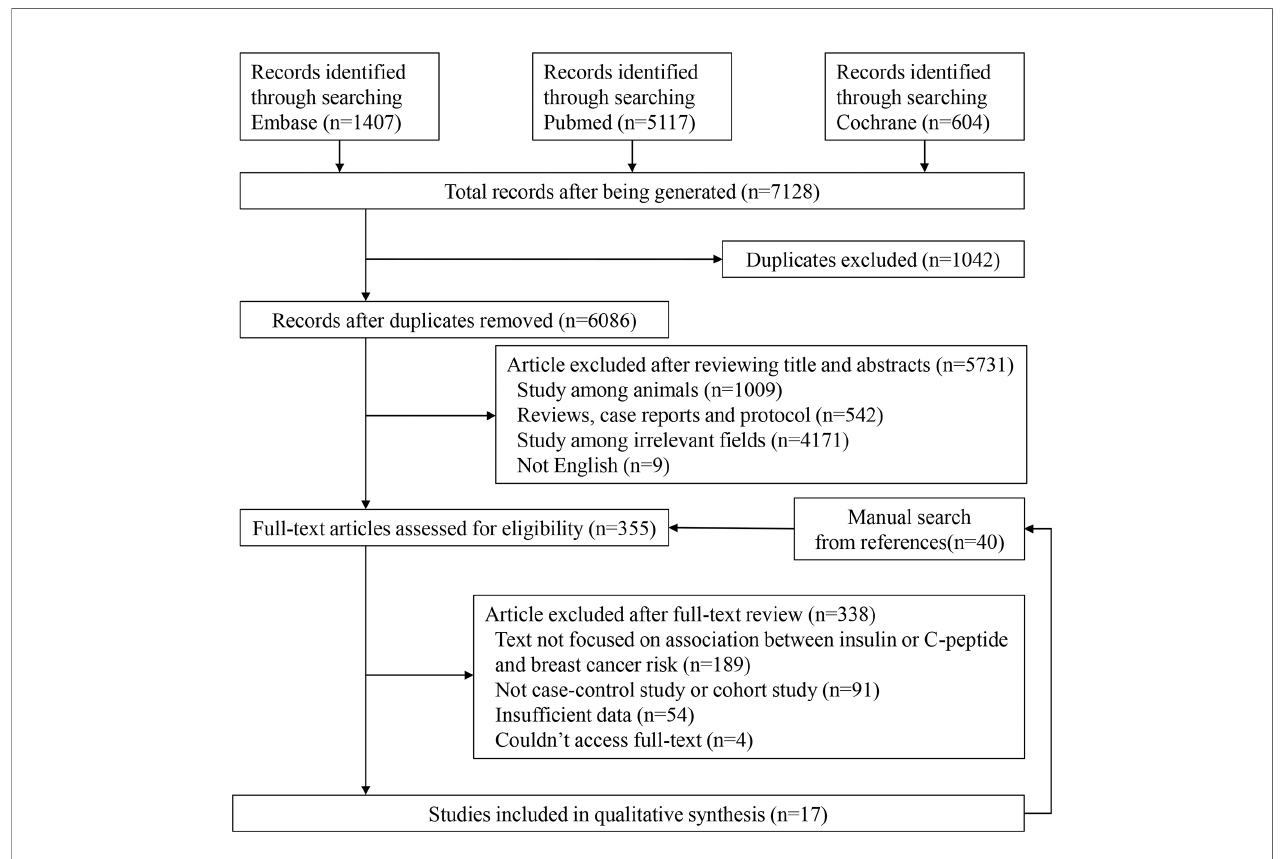
FIGURE 1 | Flow diagram of the study selection